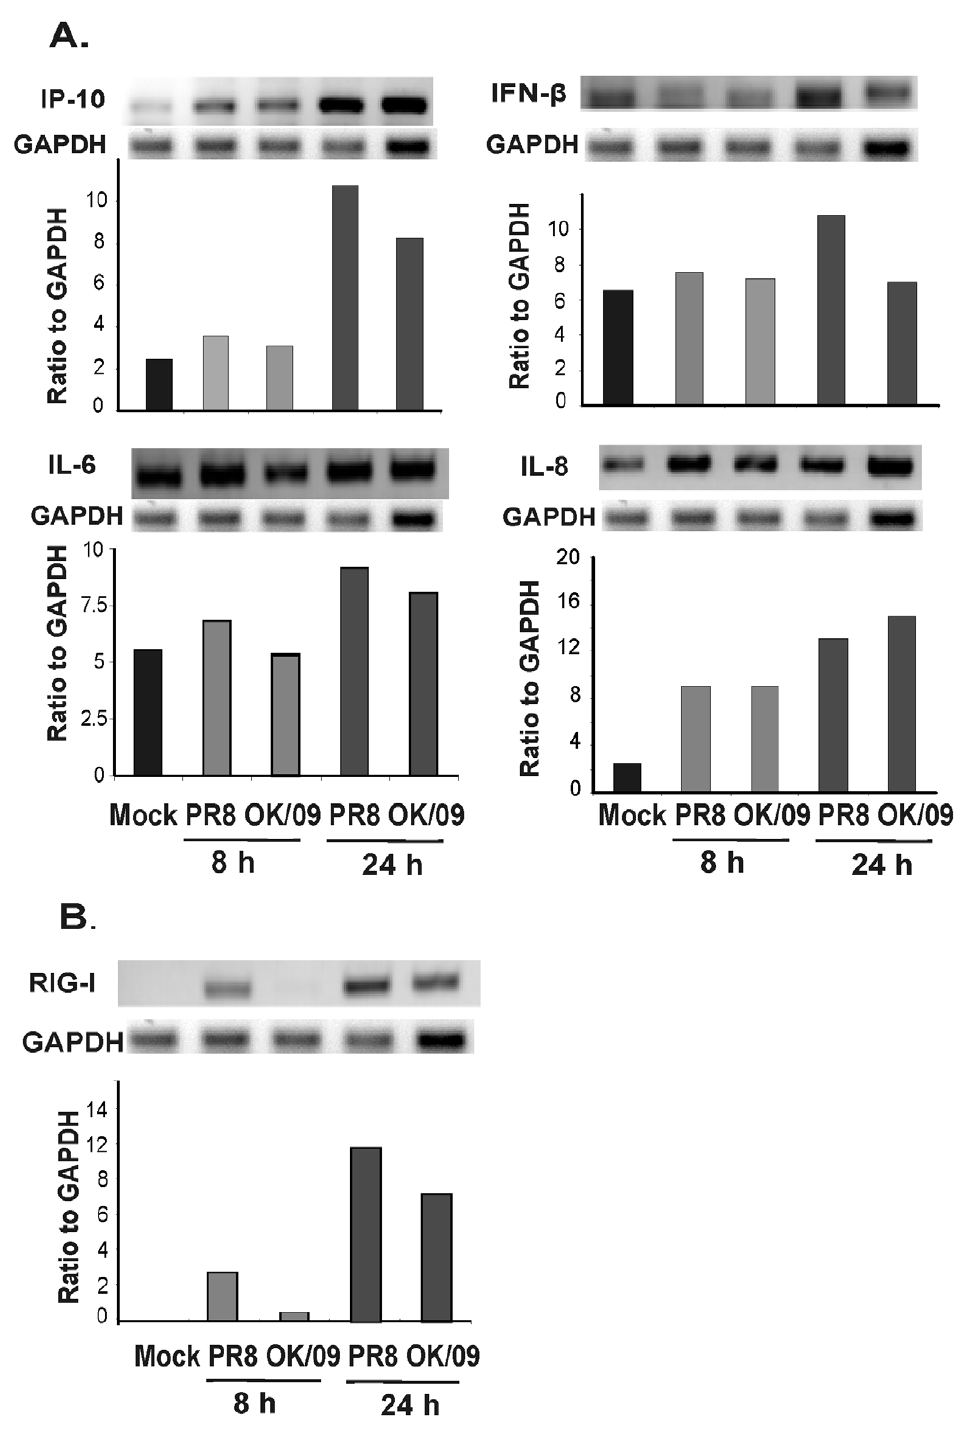
Figure 2. Pandemic OK/09 impairs host antiviral cytokine response and RIG-I response compared to PR8 in human lung. Human lung slices were exposed to 6 6 10 6 PFU/ml of PR8 or OK/09 for 8 h and 24 h. Total RNA was then isolated from lung slices. Relative end-point RT-PCR products were separated by agarose gel electrophoresis, and mRNA expression was determined by densitometry of the appropriate bands on ethidium bromide-stained gels. Transcript levels of cytokines ( A ) and RIG-I ( B ) were normalized relative to the constitutively expressed GAPDH gene. Data are representative of 3 separate experiments.